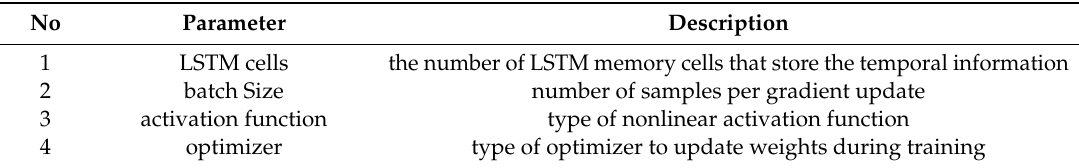
Table 2. Hyperparameters for the LSTM